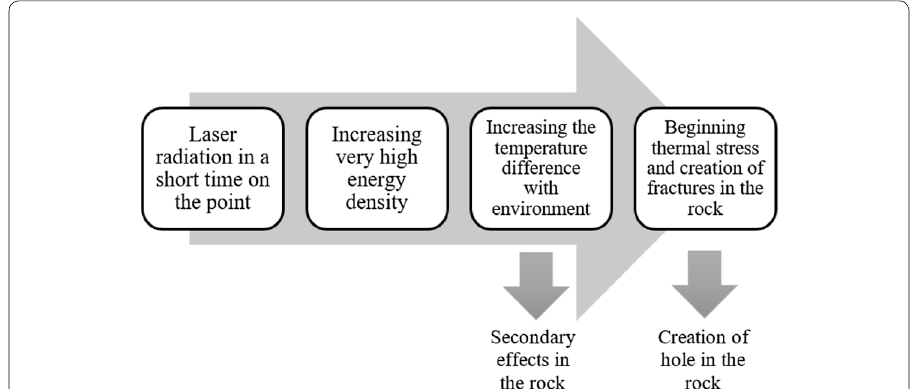
Fig. 1 Mechanism of creation a hole in the rock by